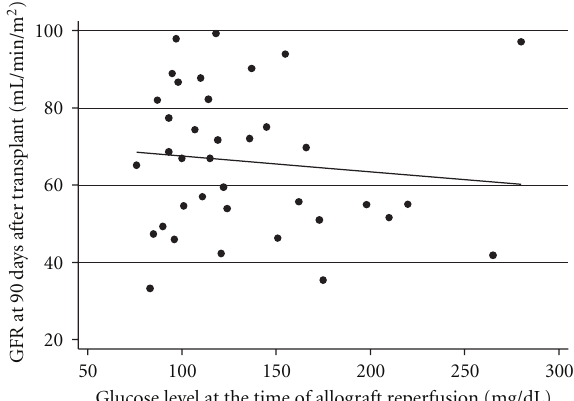
Figure 3: Scatter plot of blood glucose at the time of reperfusion against GFR at 90 days after transplant. Dots represent data points. Solid line represents linear line of best fit.